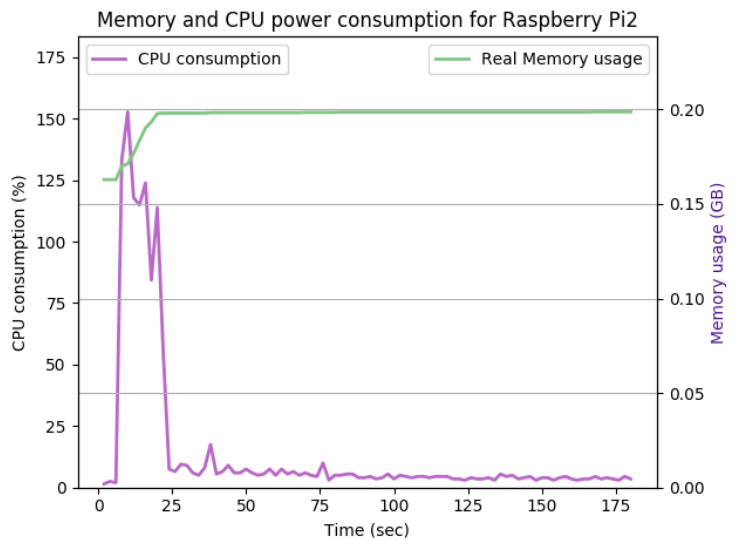
Figure 17. The CPU and memory utilization of the Raspberry Pi device